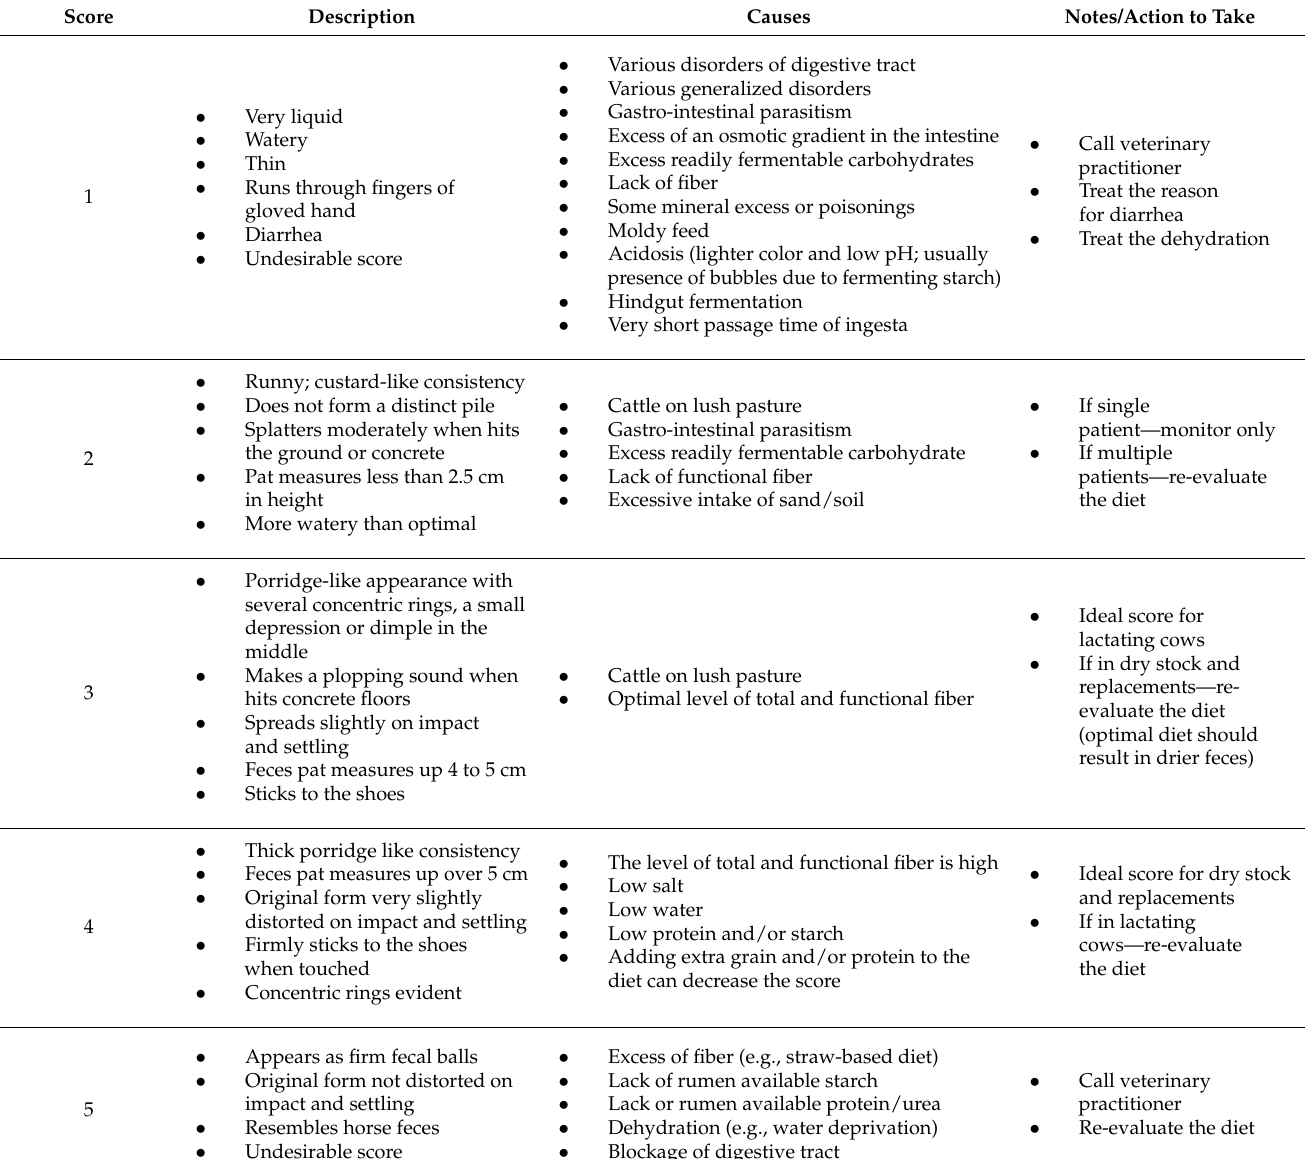
Table 7. Description of the score system of quality of feces, common nutritional causes, interpretations of the findings, and actions to be